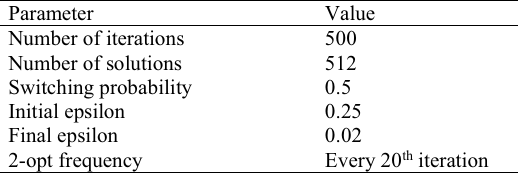
Table 3 . Flower Pollination Algorithm parameters